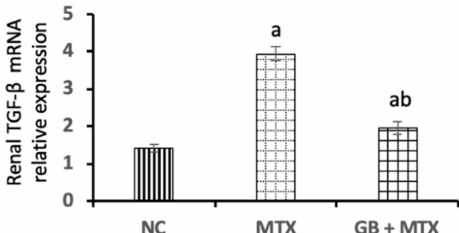
Figure 2. E ff ect of 20 mg / kg methotrexate (MTX, ip) only and when combined with 60 mg / kg Ginkgo biloba extract (GB, orally for 10 days) on transforming growth factor-beta (TGF- β ) mRNA expression in renal tissue in all studied groups. a p < 0.05 versus NC group. b p < 0.05 versus MTX group.